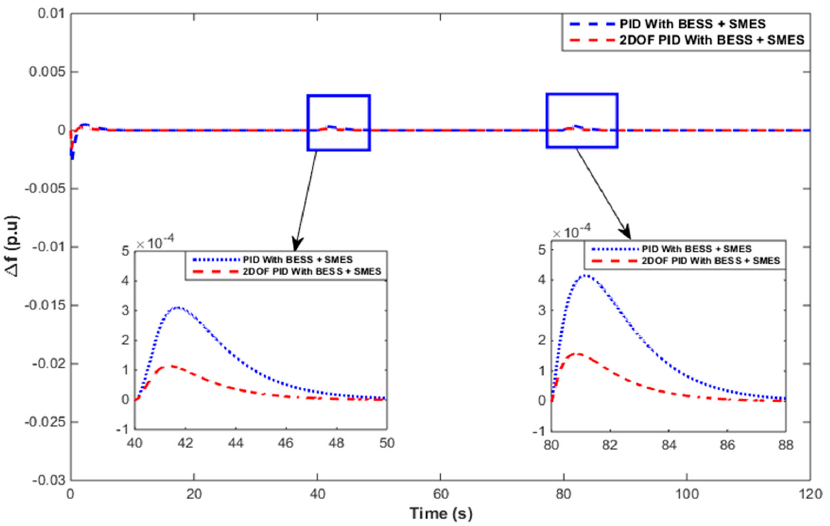
Figure 17. Comparative performances of the frequency responses of BESS (case 1) and BESS + SMES (case 3) with the FPA-optimized PID- and 2DOF-PID-controller-based hybrid energy systems.